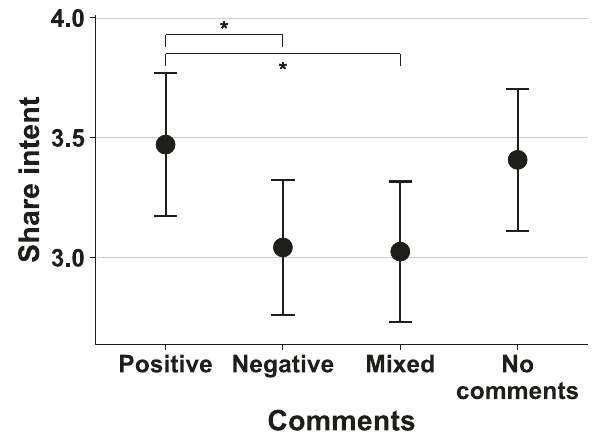
Fig. 4 Main effect of comment sentiment on share intent . Error bars represent 95% CIs, signi fi cant differences ( p < 0.011) are indicated with asterisks.